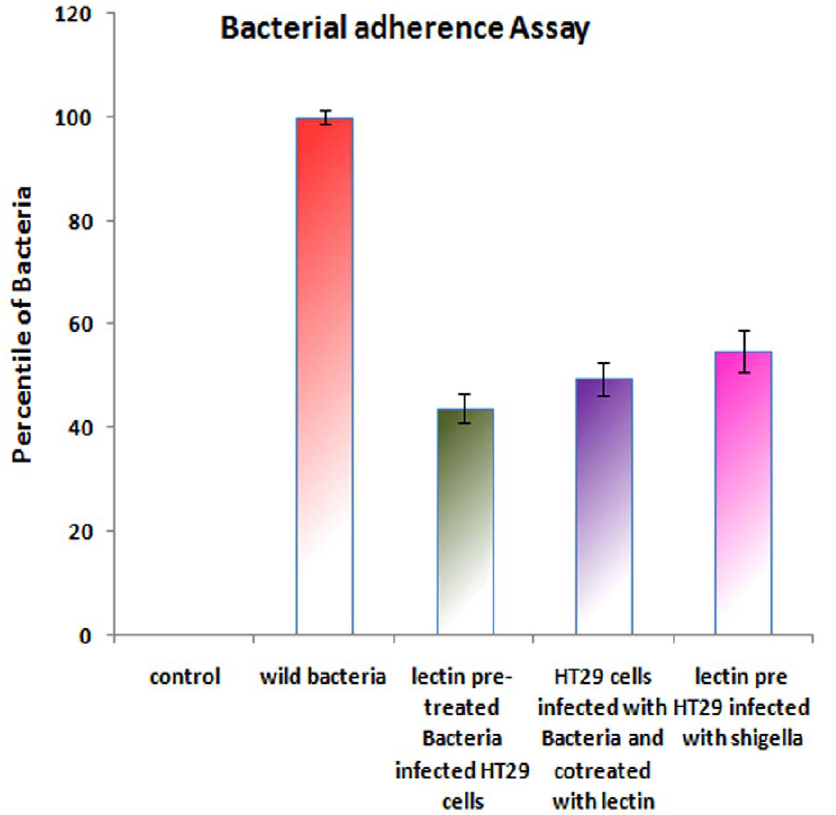
Figure 7. Bacterial adherence Assay. Adherence of Shigella dysenteriae to HT29 cells was significantly decreased in presence of lectin when compared adherence of Shigella dysenteriae to HT29 cells in absence of lectin. p . 0.001 is considered as highly significant. p Value mentioned in the above graph is compared with adherence of Shigella dysenteriae to HT29 cells in absence of lectin.